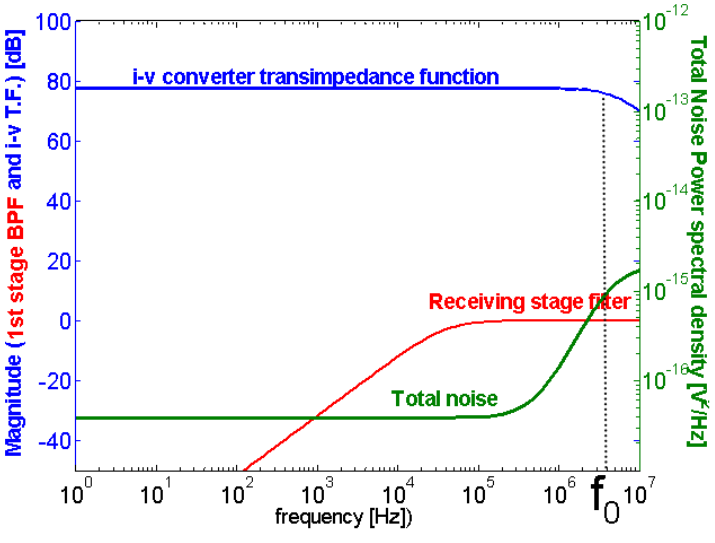
Figure 9. Frequency domain plots: sensor transimpedance function, filter transfer function (only lower cutoff frequency is shown) and noise power